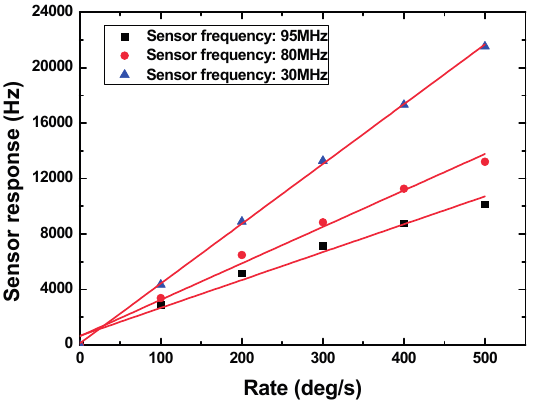
Figure 9. The experimental sensor response depending on various operation frequencies, piezoelectric substrate: 128°YX LiNbO 3 , Au dot thickness: 900